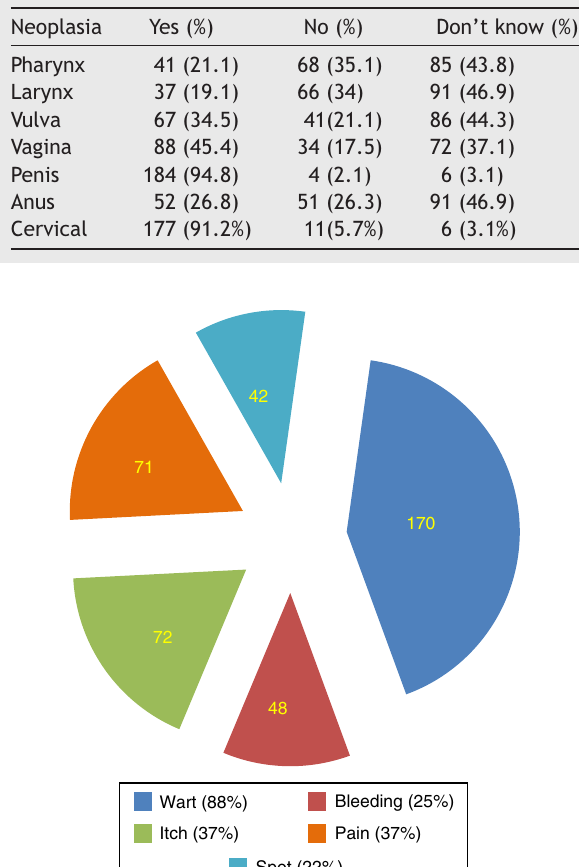
Table 2 Proportion of responses about the participation of HPV in the pathogenesis of cancer in different anatomical sites.